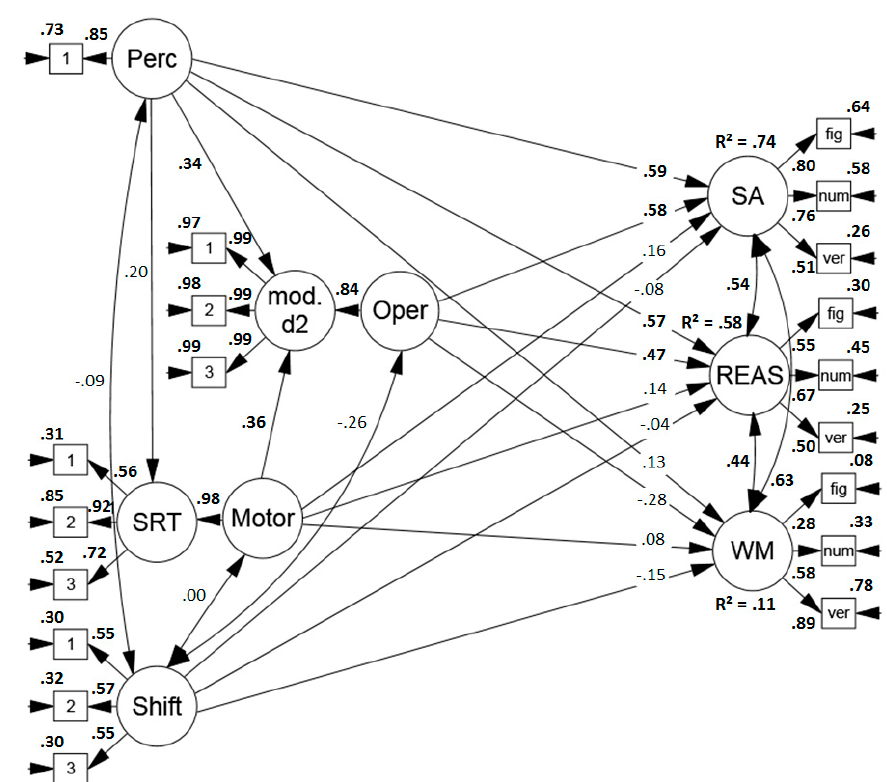
Figure 3. Standardized solution of the model predicting performance in sustained attention tests (convergent validity), reasoning, and working memory span tasks (discriminant validity) based on the proposed process model of sustained attention tests. Significant results are printed in boldface. Perc = perceptual speed, mod. d2 = modified d2, Oper = operation speed, SRT = simple reaction time task, Motor = motor speed, Shift = item shifting speed, SA = sustained attention, REAS = reasoning, WM = working memory span, fig = figural task, num = numerical task, verb = verbal task.